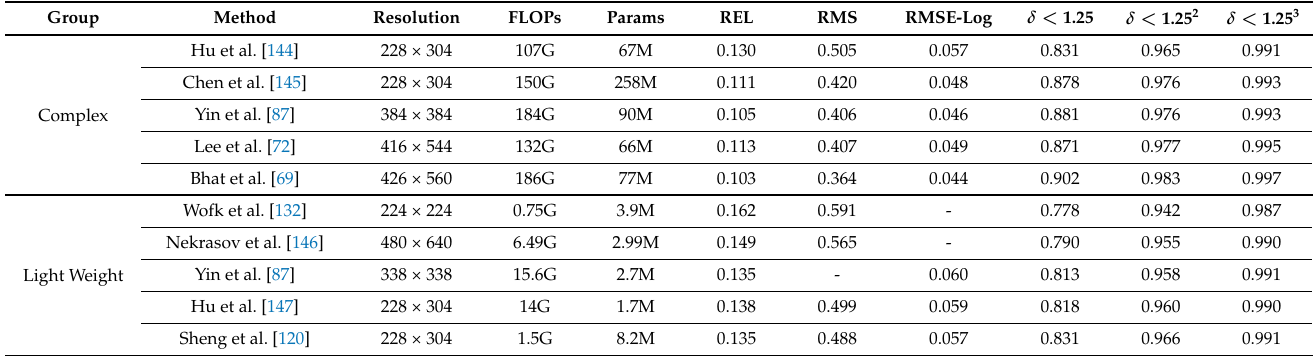
Table 7. Comparison of complex and lightweight models based on the NYUDv2